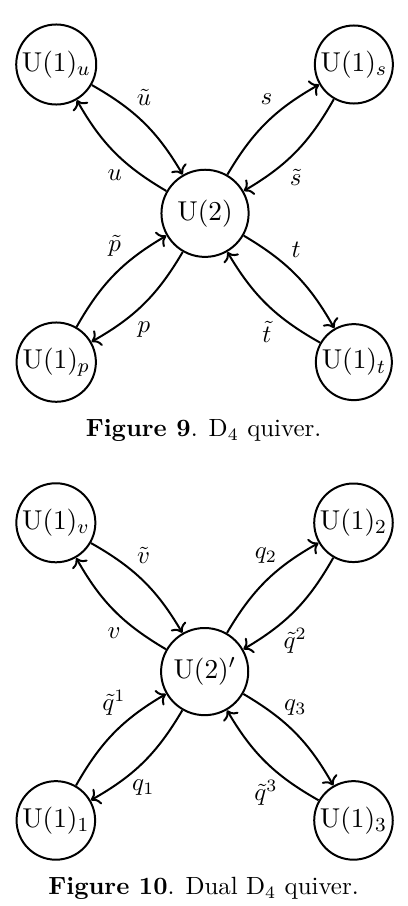
Figure 10 . Dual D 4